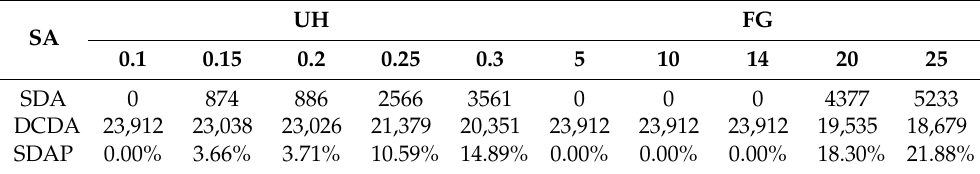
To graphically depict the delivery routing decisions under different values of UH, we portray the delivery routing distribution during periods t = 2 and t = 3 in Figure 6, respectively. Figure 6a,b describe the routing decisions under the circumstance of UH = 0.1, and Figure 6c,d assume UH = 1.5.